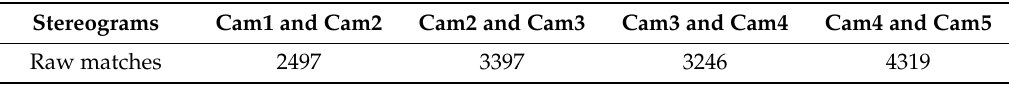
Table 4. The number of raw matches for stereograms.